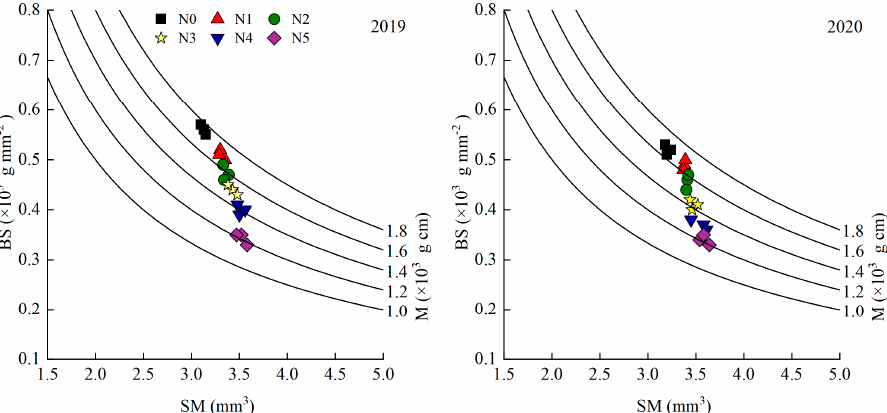
Figure 2. Relationship between SM, BS and M of rice under dry cultivation under different N appli-